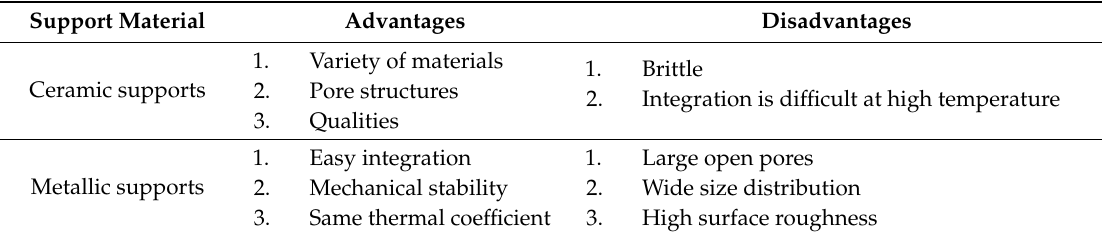
Table 1. Di ff erence between ceramic and porous metallic supports